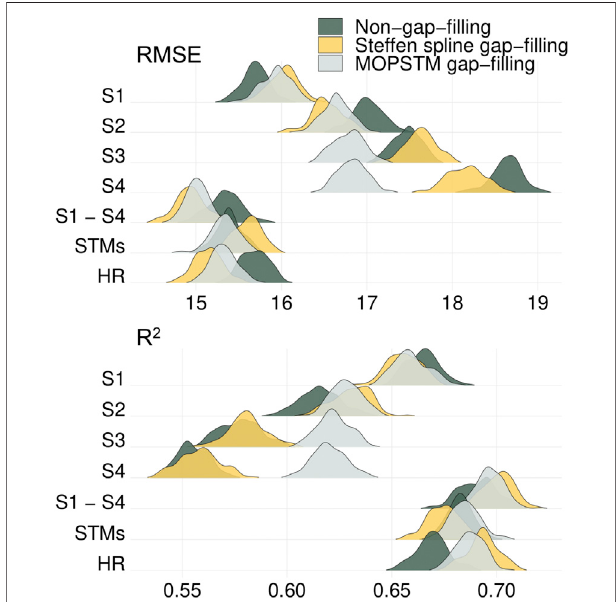
FIGURE 4 | Bootstrapping results for the variables using non-gap- fi lling versus using gap- fi lling (Steffen spline and MOPSTM methods), predicting the tree canopy cover. The kernel densities are based on 100 bootstrap samples forthetested Landsat re fl ectanceand vegetation indices.Awidespread in kernel density indicates variation among the bootstrap samples. Abbreviations: S1 denotes dry and hot season (January – February), S2 denotes long rains (March – May), S3 denotes dry and cool season (June – September), S4 denotes short rains (October – December), S1 – S4 is a combination of all the